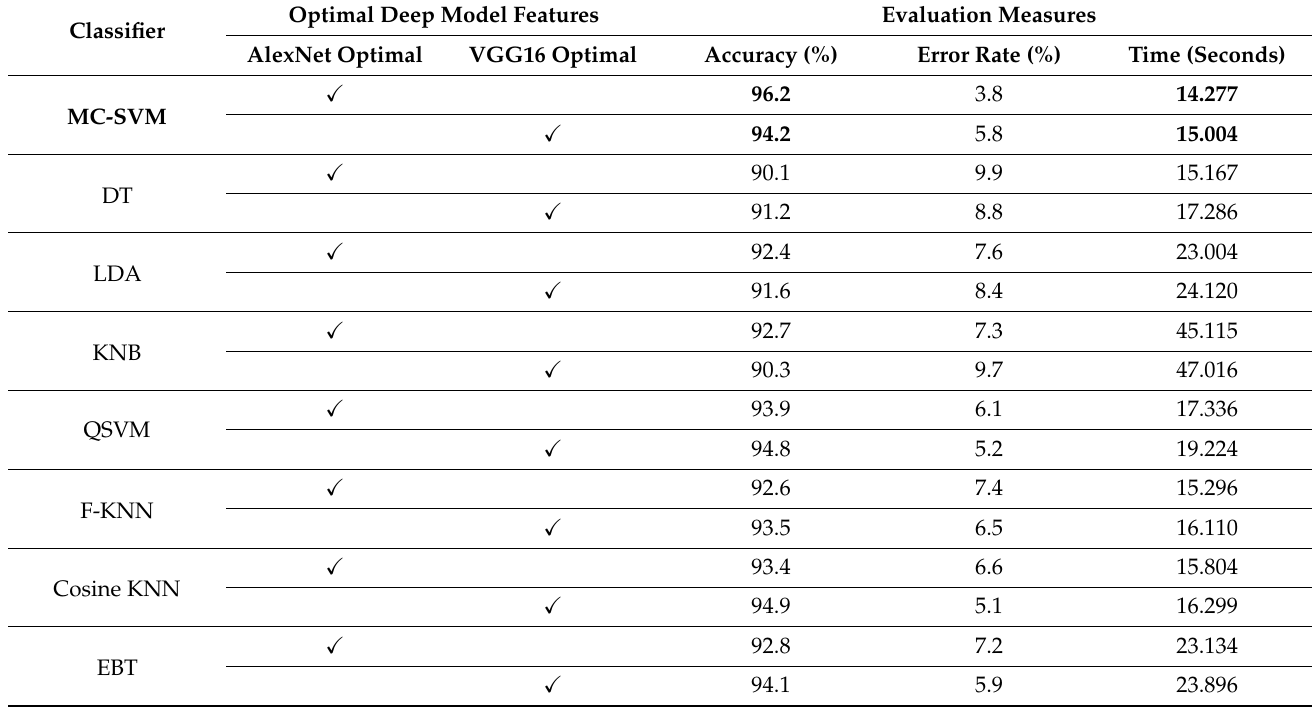
Table 3. Classification accuracy achieved using the optimal feature selection